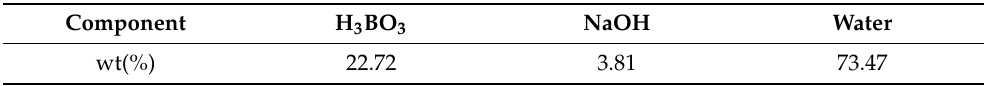
Table 2. Mix design of high-concentration borate solution.